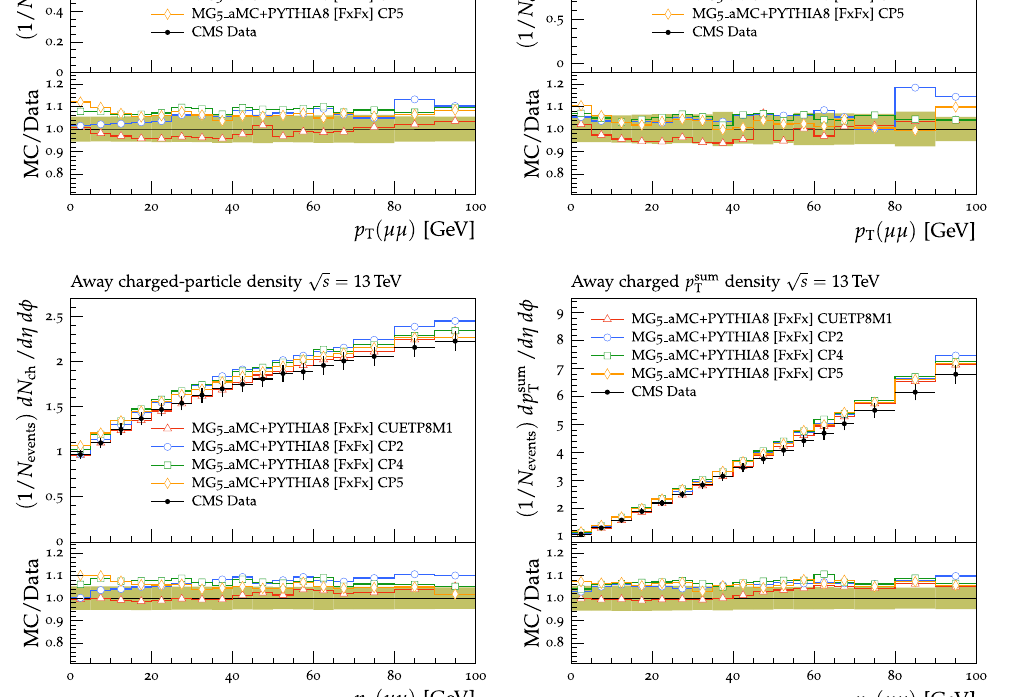
tunes CP2 and CP4. The ratios of simulations to the data (MC/Data) (right) in the T are also shown, where the shaded band indicates the total experimental √ s = 13TeV uncertainty of the data. Vertical lines drawn on the data points refer to the total uncertainty in the data. Vertical lines drawn on the MC points refer to the statistical uncertainty in the predictions. Horizontal bars indicate the associated bin